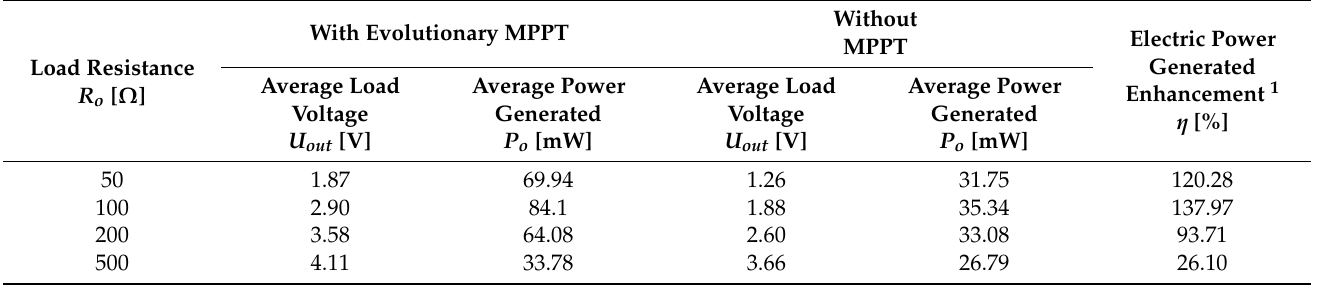
Table 1. The average levels of voltages and load powers